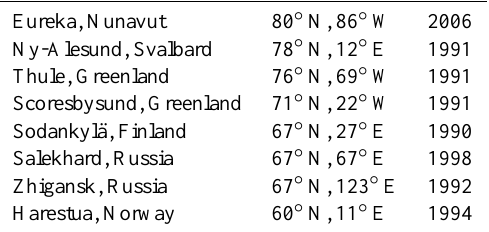
Table 1. SAOZ Arctic stations, latitude, longitude and date of